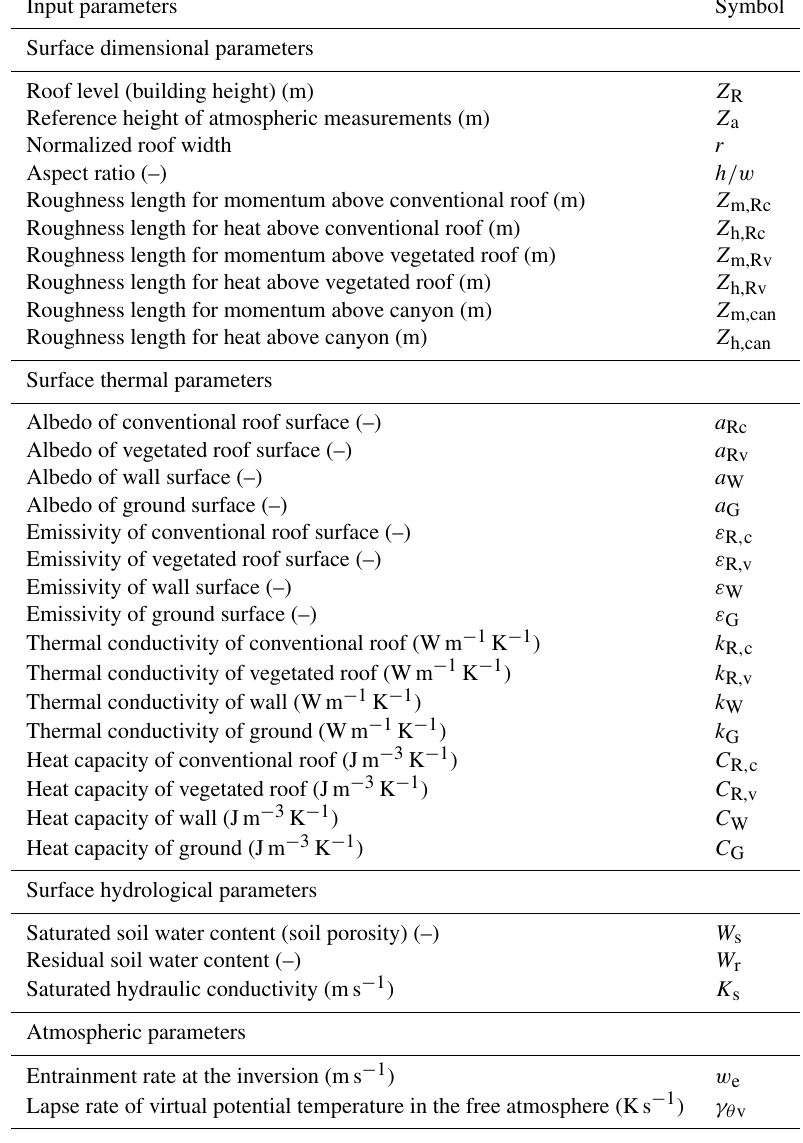
Table 1. Input parameters of the coupled SLUCM–SCM numerical framework. Input parameters Symbol Surface dimensional parameters Reference height of atmospheric measurements (m) Roughness length for momentum above conventional roof (m) Z m,Rc Roughness length for heat above conventional roof (m) Z h,Rc Roughness length for momentum above vegetated roof (m) Z m,Rv Roughness length for heat above vegetated roof (m) Z h,Rv Roughness length for momentum above canyon (m) Z m,can Roughness length for heat above canyon (m) Z h,can